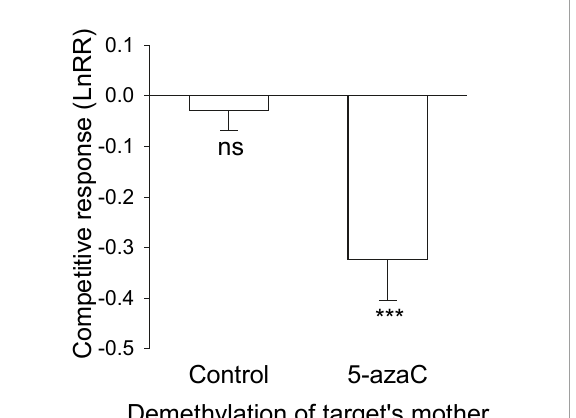
FIGURE2 The effect of DNA demethylation of the target’s mother on the competitive response of the target plant of Eichhornia crassipes. Bars show means + SE. Symbols (*** P < 0.001) indicate significant difference from zero (by one-sample t -test). P. stratiotes and E. crassipes ( Figure 1 ), which is consistent with previous findings on other aquatic plants (Zhao, 2006; Jampeetong and Brix, 2008; Zhang et al., 2020). This effect